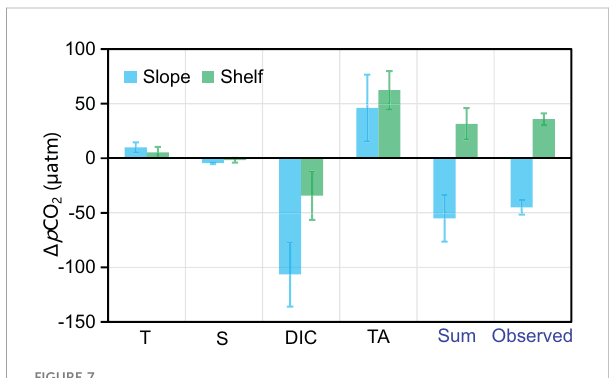
FIGURE 7 The quanti fi cation of each driver on temporal dynamics of sea surface p CO 2 in the Slope of the Bering Sea (A) and the Shelf (B) . ‘ Sum ’ is the accumulative effect from T, S, DIC, and TA, and ‘ observed ’ is the observed p CO 2 change from July to